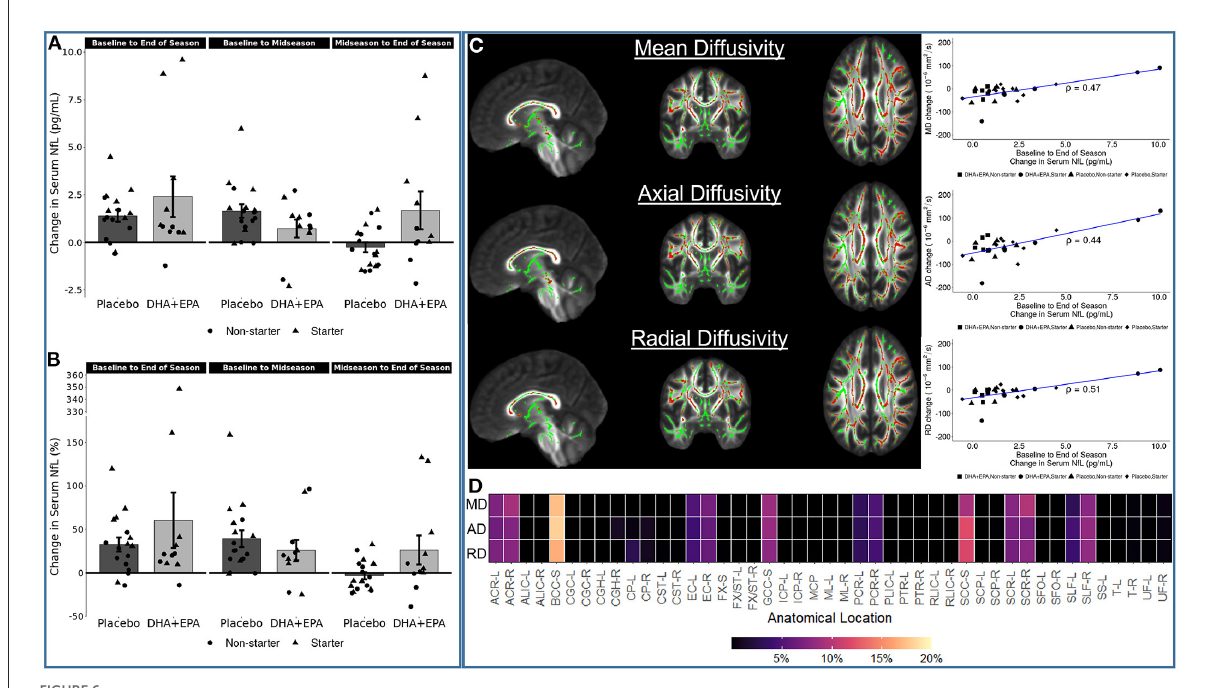
FIGURE6 Associations between serum neurofilament light (NfL) change and diffusion tensor metric changes. Serum NfL increased in the majority of participants from baseline to end of season, irrespective of group (A,B) . Increasing NfL was positive correlated with mean diffusivity (MD), axial diffusivity (AD), and radial diffusivity (RD) [ (C) ; all family-wise error corrected p < 0.05]. Statistically significant voxels were primarily located in the corpus callosum, bilateral corona radiata, and bilateral external capsule (D) . The heatmap in (D) shows the proportion of statistically significant voxels localized to a given region of interest in the JHU ICBM-DTI-81 atlas. Not all voxels could be assigned to a region based on the spatial extent of the atlas not covering all of the white matter. Region names associated with the abbreviations on the x -axis are reported in Supplementary Table